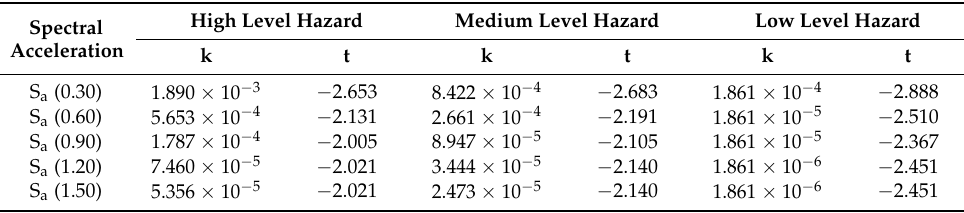
Table 6. Calculated parameters k and t used in Equation